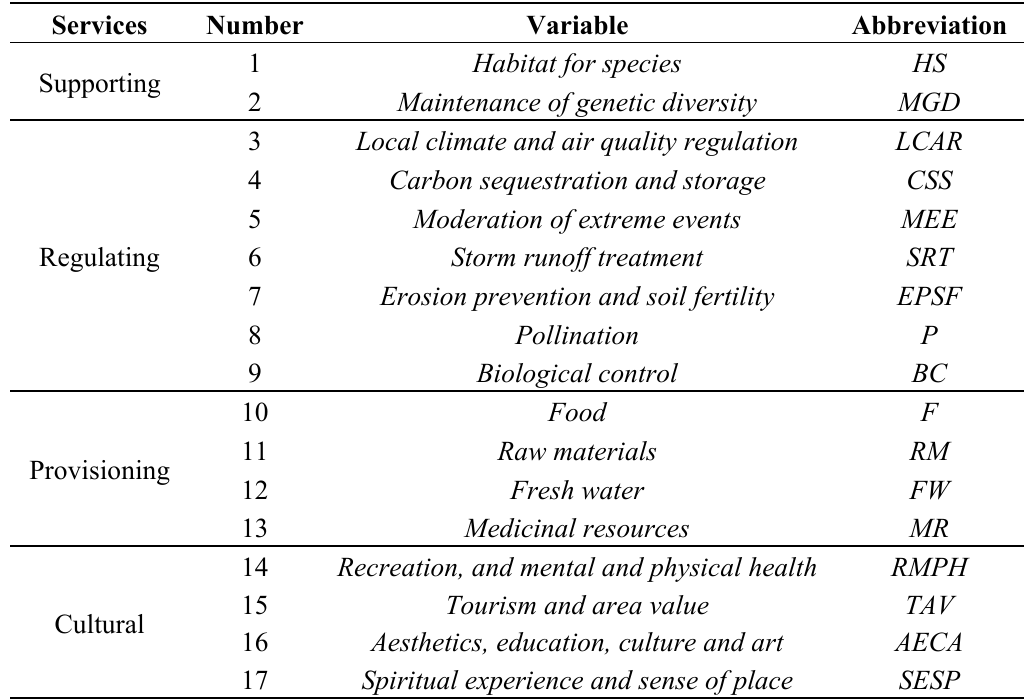
Table 1. Ecosystem service